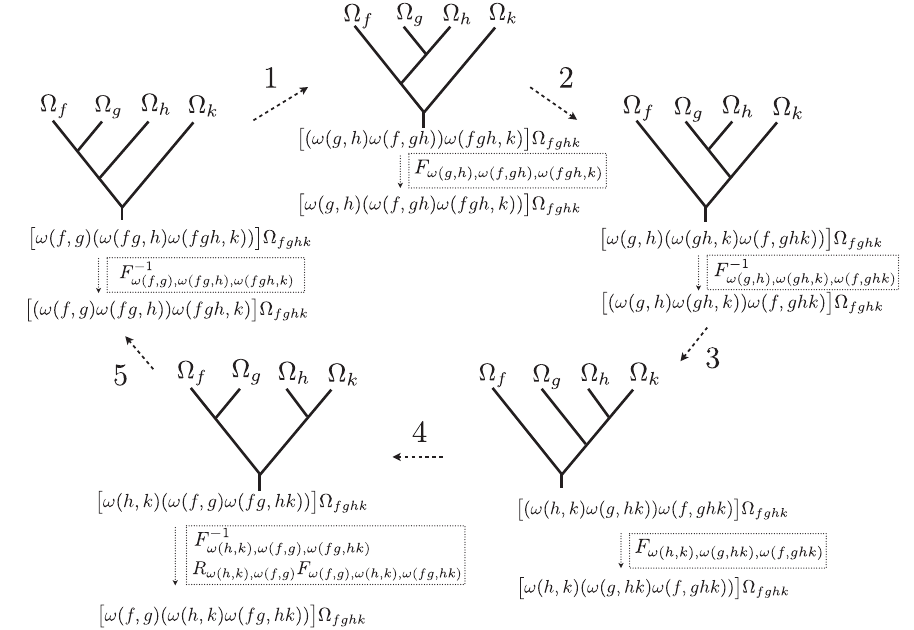
FIG. 4. Graphical representation of the pentagon equation involving four fluxes. According to Theorem 8.10 of Ref. [23], this pentagon equation can fail by an overall phase ν ð f; g; h; k Þ , and the phase can be computed as a product of F and R matrices of the original theory, applied to anyons determined by the fractionalization class ω . These F and R matrices can intuitively be thought of as contributions coming from five additional steps in the pentagon equation, in which the various ω anyons are reassociated or exchanged as required. We stress that this is just a mnemonic for the precise formula given in Theorem 8.10 of Ref.